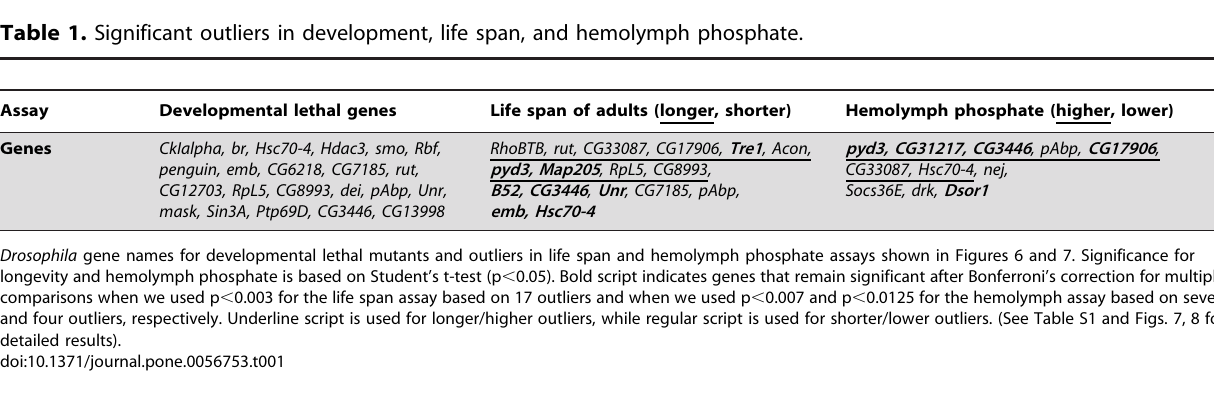
Table 1. Significant outliers in development, life span, and hemolymph phosphate.